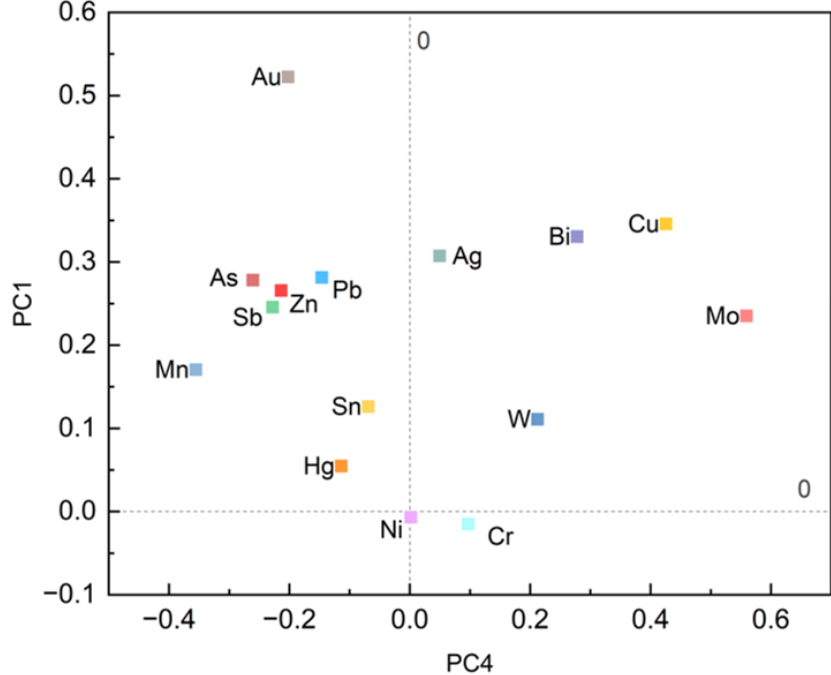
Figure 19. Loading of PC1 and PC4 in the geochemical elements. The points delineate different elements; the numerical value of the horizontal and vertical coordinates represents the loading.